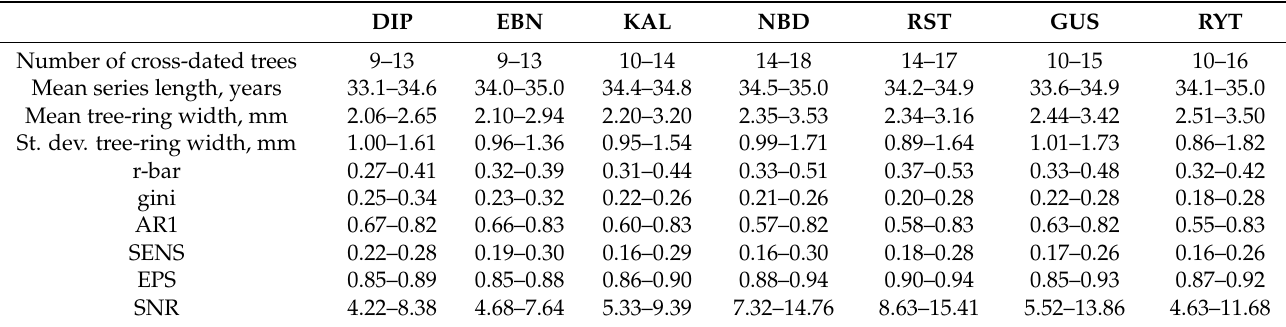
Table 3. General statistics of the cross-dated datasets of tree-ring width of the studied south-eastern Baltic provenances of Scots pine. Ranges of the values across the studied trials are shown. AR1—first order autocorrelation, r-bar—mean interseries correlation, gini—gini coefficient, SENS—mean sensitivity, EPS—expressed population signal, and SNR—signal to noise